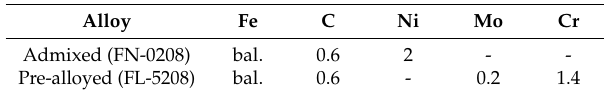
Table 1. Main alloying elements of the studied materials (wt.